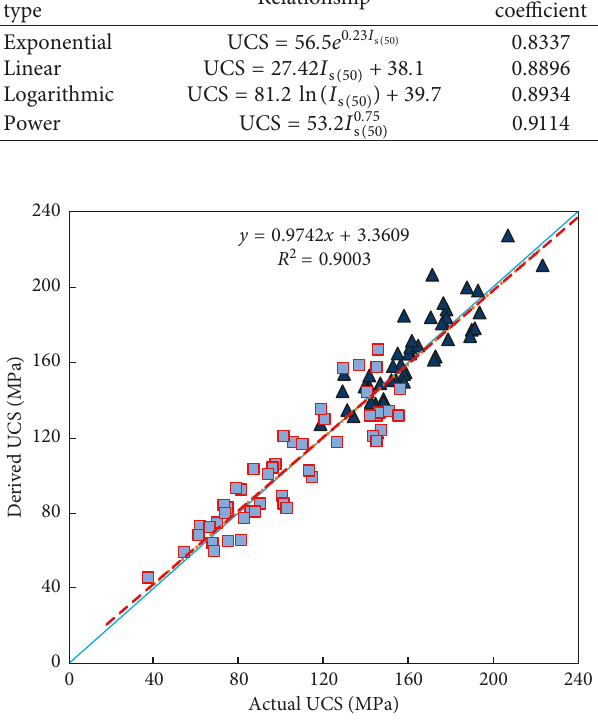
Figure 10: Cross correlation of actual and derived values of UCS from